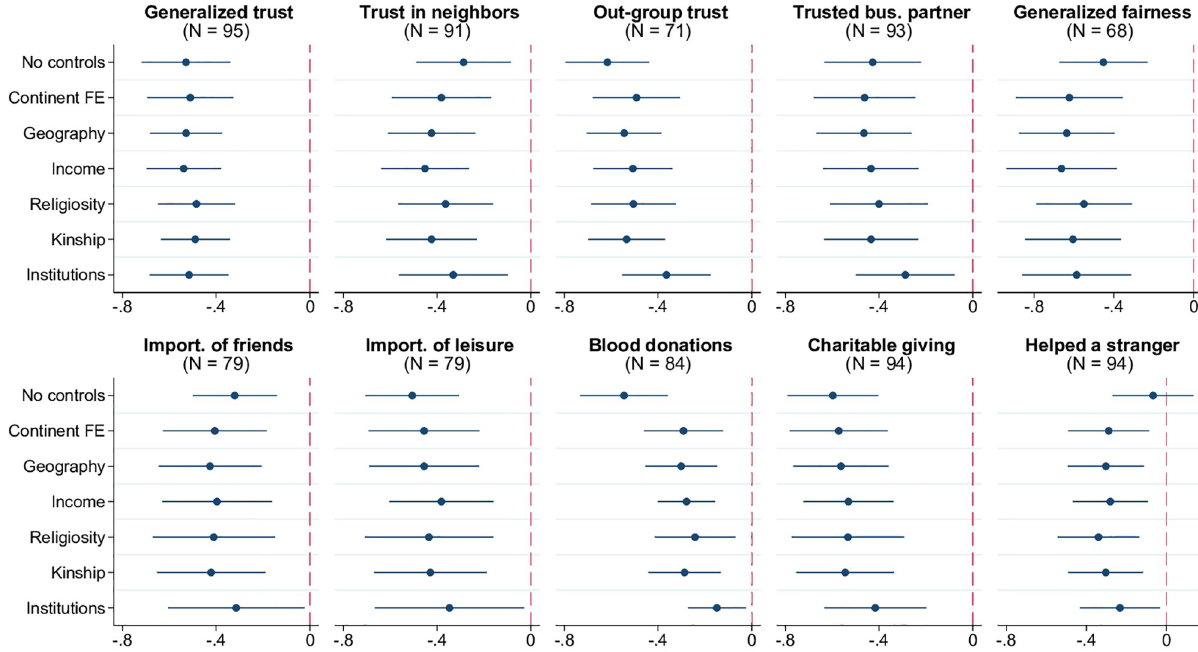
Fig 5. Witchcraft beliefs and ruptured social relations. Each panel of the figure presents the results of estimating 7 different models, in which the metric of social relations indicated in the panel title is regressed on the prevalence of witchcraft beliefs, along with a set of control variables. The latter is defined as follows according to the tickmarks on the vertical axis: 1) none for “No controls”, 2) only continental fixed effects for “Continent FE”, 3) continental fixed effects and baseline geographic controls (absolute latitude, terrain ruggedness, agricultural suitability of land, distance to the coastline) for “Geography.” The remaining 4 models, named “Income,” “Religiosity,” “Kinship,” and “Institutions” include, respectively, real GDP per capita, average religiosity, kinship intensity index, and the rule-of-law index (in addition to continental fixed effects and geographic variables). The round marker represents the point estimate for the coefficient on the prevalence of witchcraft beliefs, and the linear segment around each marker is the respective 95% confidence interval based on heteroskedasticity-robust standard errors. Sample size N indicated in parentheses. The key variables are standardized to have zero mean and unit standard deviation in relevant